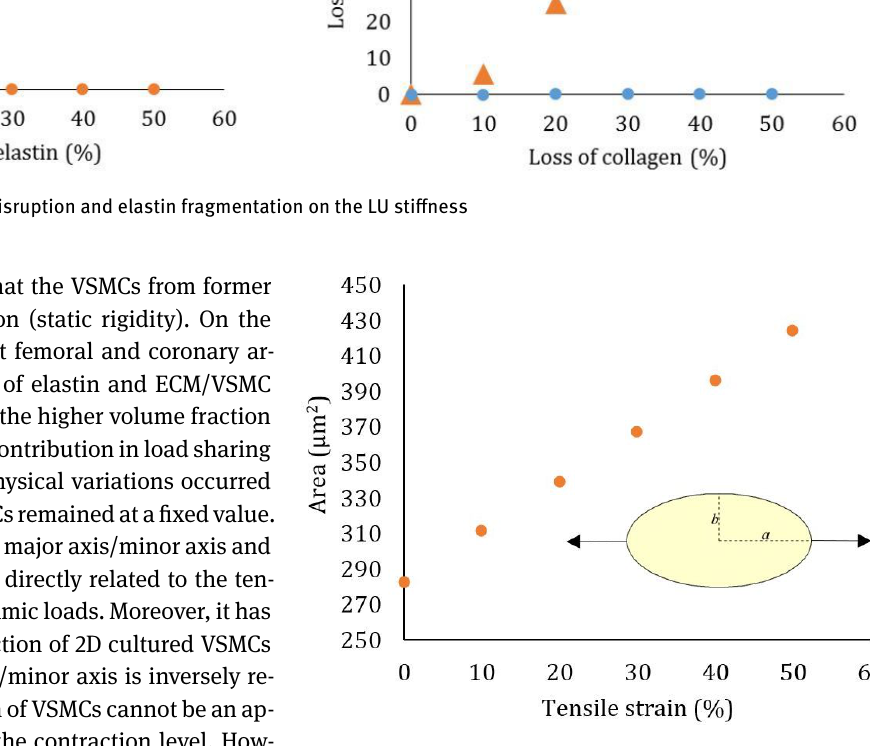
Figure 7: The calculated area of VSMC with respect to the stretch